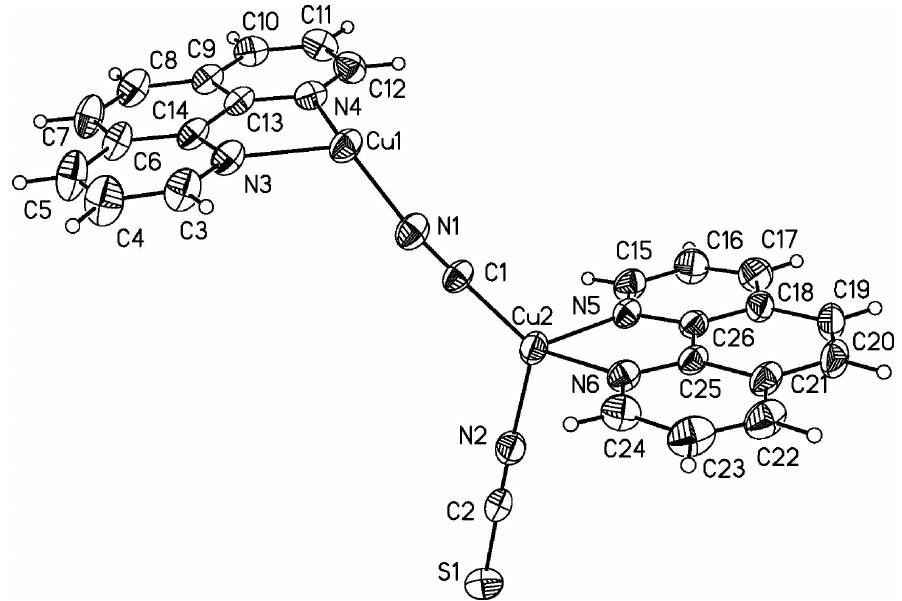
Figure 1 The structure of the title compound, with displacement ellipsoids for the non-hydrogen atoms drawn at the 30% probability